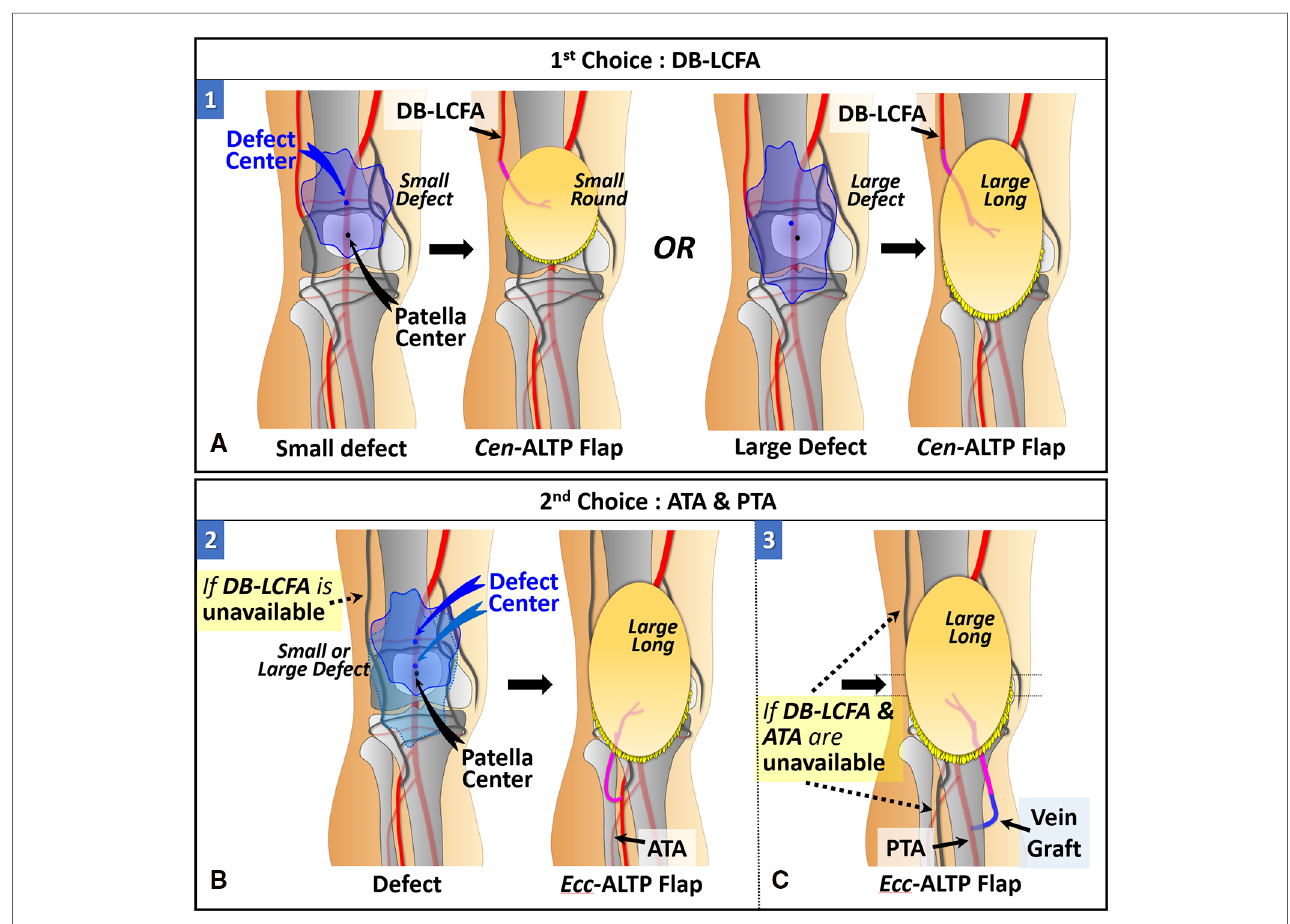
FIGURE 5 Algorithmic options for soft tissue defects above the patella in which the defect center is located above the patella center. (The number in each fi gure piece indicates the corresponding option number in the algorithm) ( A ) DB-LCFA is the fi rst choice as a recipient vessel because of its proximity to the defect and easy accessibility. Depending on the defect size, Cen-ALTP fl ap with a small round or large long skin paddle can be used for free tissue transfer. ( B ) If the DB-LCFA is unavailable to use, ATA (1st choice) or PTA (2nd choice) could be used as a recipient vessel irrespective of the defect ’ s size. Firstly, If only DB-LCFA is unavailable as a recipient vessel, Ecc-ALTP fl ap with a large long skin paddle, which is anastomosed to ATA, is used for free tissue transfer. ( C ) Secondly, if both DB-LCFA and ATA are unavailable as recipient vessels, Ecc-ALTP fl ap with a large long skin paddle is transferred using PTA accompanied by a vein graft. (DB-LCFA, descending branch of the lateral circum fl ex femoral artery; ALTP fl ap, anterolateral thigh perforator fl ap; Cen-ALTP fl ap, ALTP fl ap with centrally located perforators; ATA, anterior tibial artery; PTA, posterior tibial artery; Ecc-ALTP fl ap, ALTP fl ap with eccentrically located